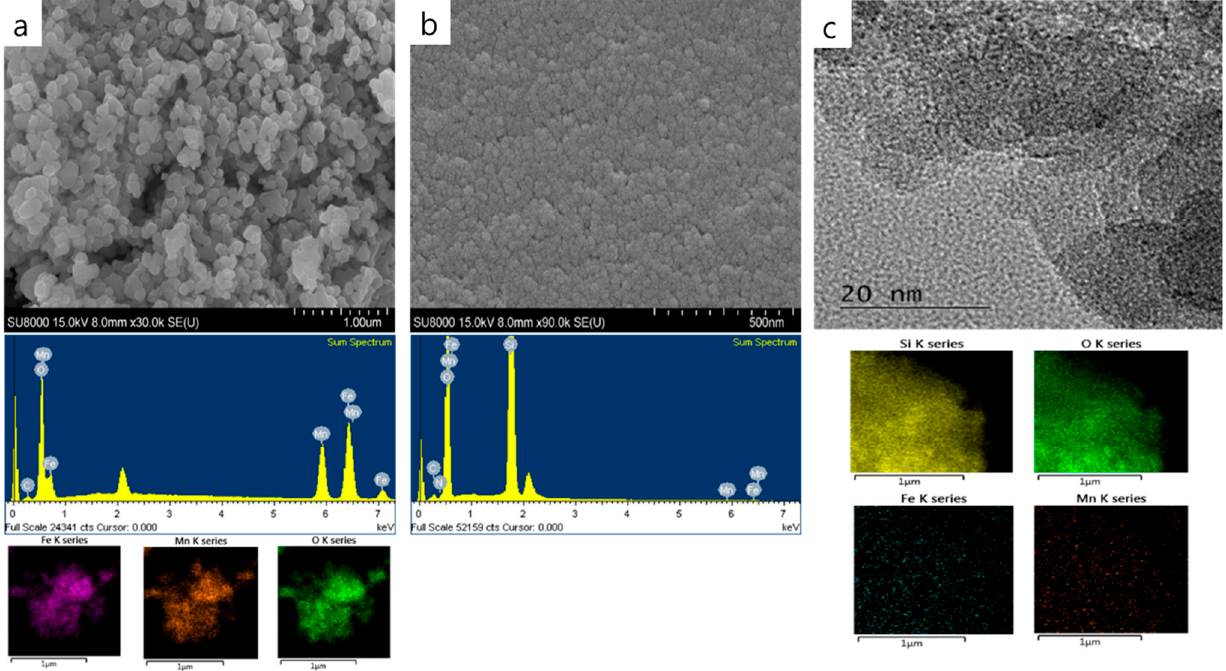
Figure 1. Images for ( a ) SEM-EDS of Fe 2 O 3 /Mn 2 O 3 nanoparticles (FM-NPs), ( b ) SEM-EDS of Fe 2 O 3 /Mn 2 O 3 @SiO 2 (FMS), and ( c ) HRTEM-EDS of FMS.